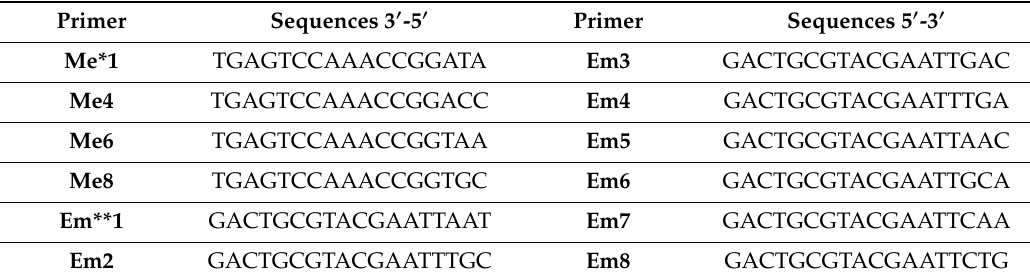
Table 6. Forward and reverse SRAP primer